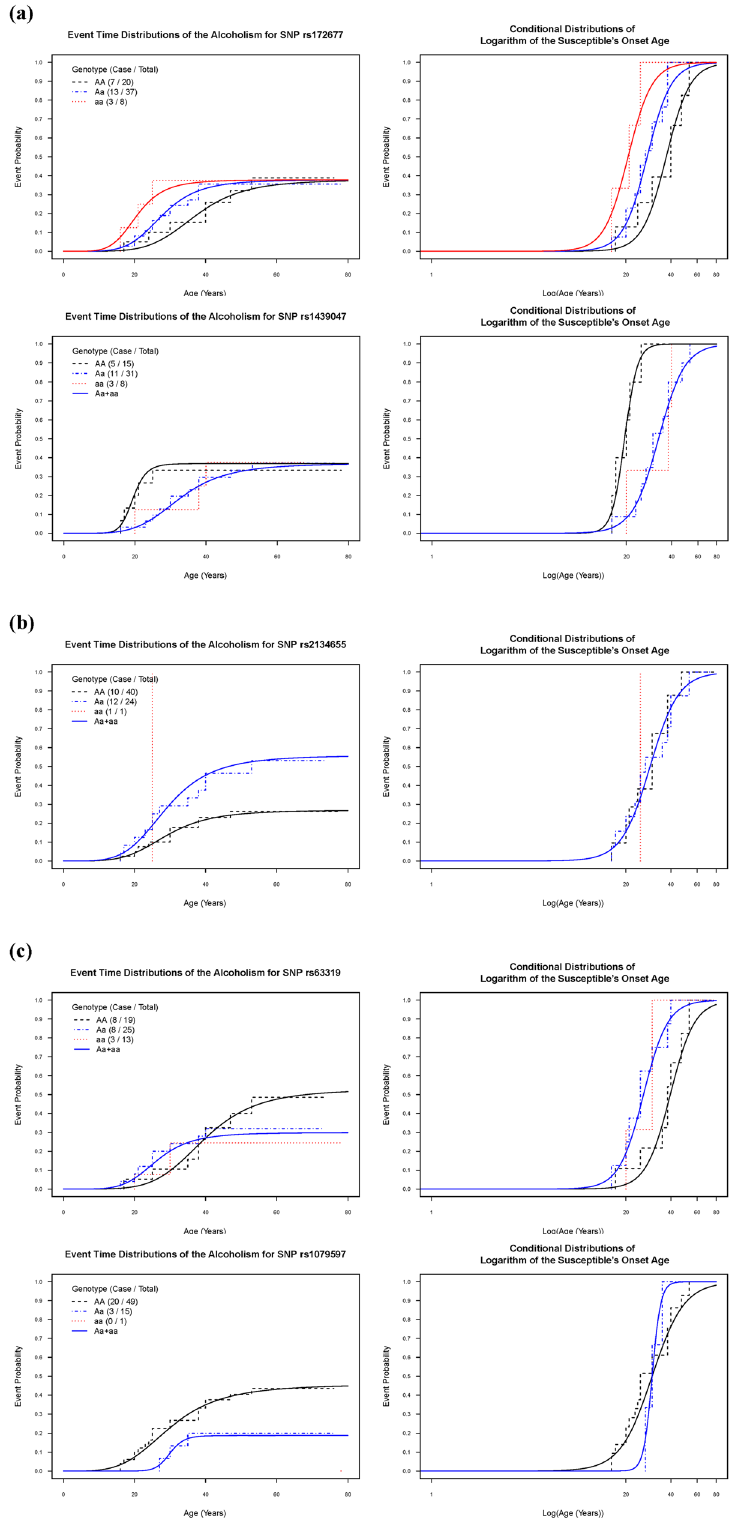
Figure 1. Kaplan–Meier (step function) and mixture regression (solid smooth curve) estimators of overall and conditional event curves for alcoholism onset age stratified by genotypes of a single SNP. ( a ) SNPs with an equal probability of susceptibility only: rs172677 and rs1439047, ( b ) SNPs with unequal probabilities of susceptibility only: rs2134655, ( c ) SNPs with unequal susceptibilities and onset age: rs63319 and rs1079597. Note that all the Kaplan–Meier curves are stratified by genotypes AA , Aa and aa while estimated mixture regression curves are stratified by genotypes AA and Aa + aa except the SNP